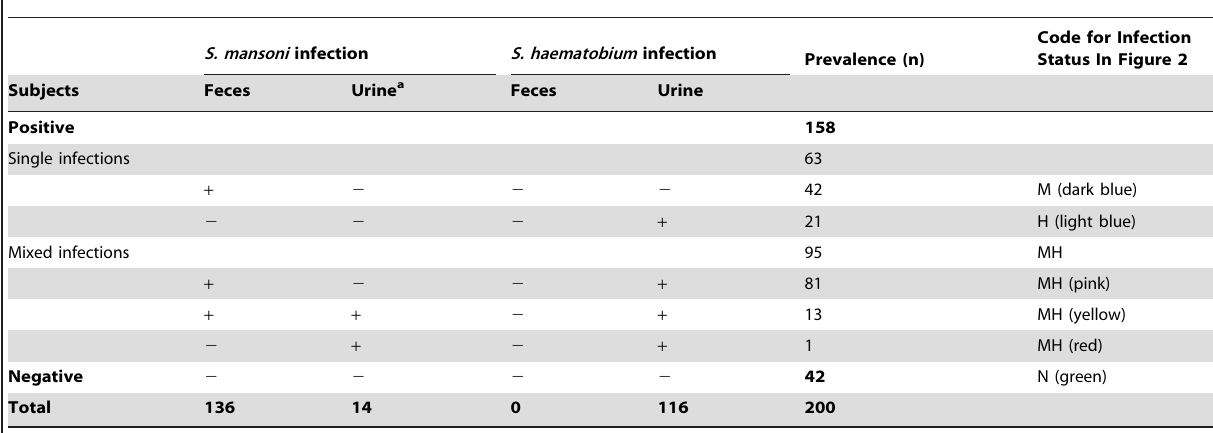
Table 1. Schistosoma infections in the study population.